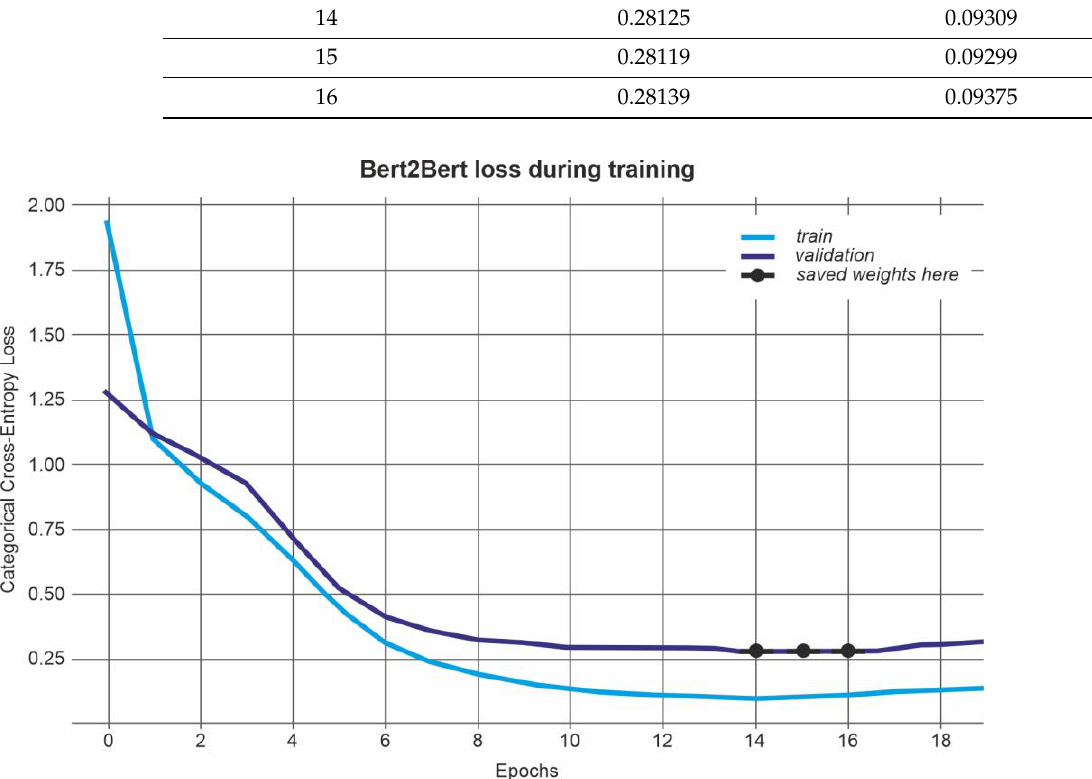
Table 1. The categorical cross-entropy loss (CCEL) values. Epochs